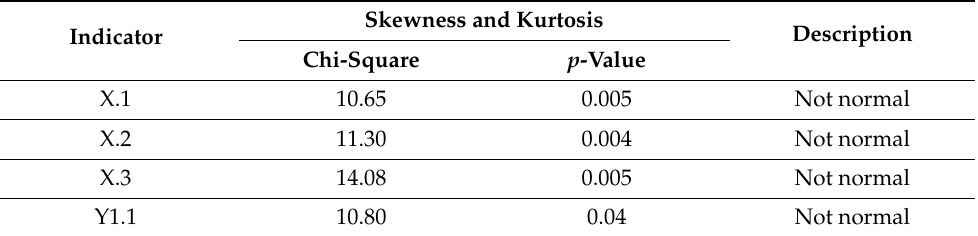
Table 8. Univariate Normality Test